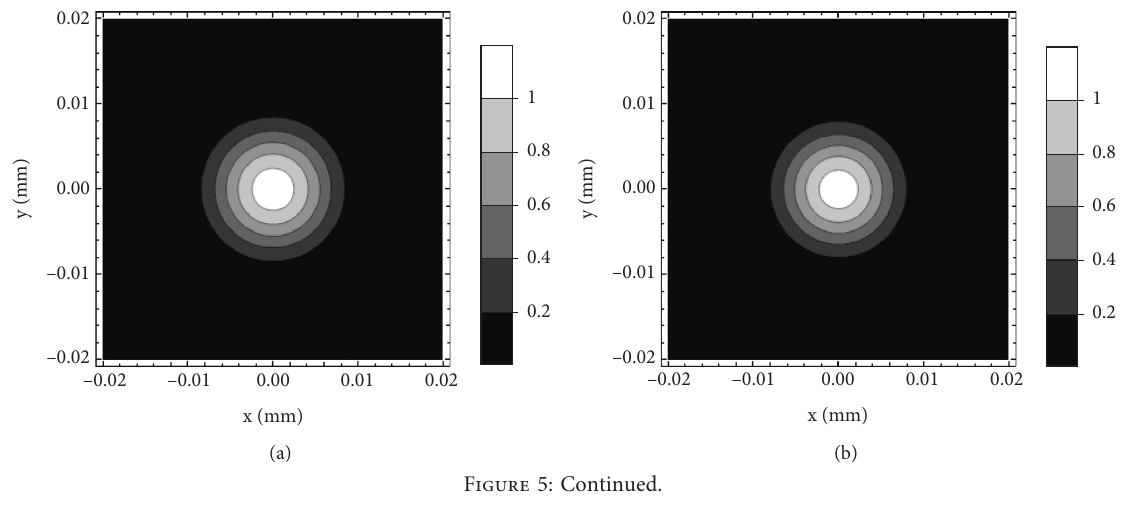
Figure 4: Intensity patterns of the partially coherent Lorentz beam with incident beam widths of w with coherence widths σ � 8mm at different propagation distances in along focal length of logarithmic axicon. (a) z � 100mm. (b) z � 140 mm. (c) z � 180 mm. (d) z �